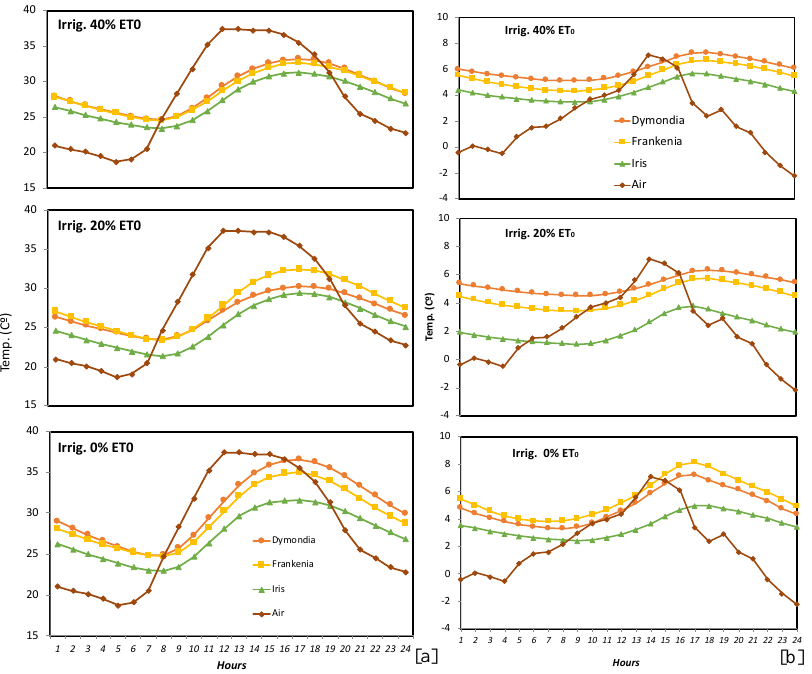
Figure 3. Hourly air and substrate temperatures for all three irrigation treatments of D. margaretae , F. laevis , and I. lutescens : ( a ) on a typical summer’s day (17 August 2009); ( b ) on a typical winter’s day (17 December 2009).